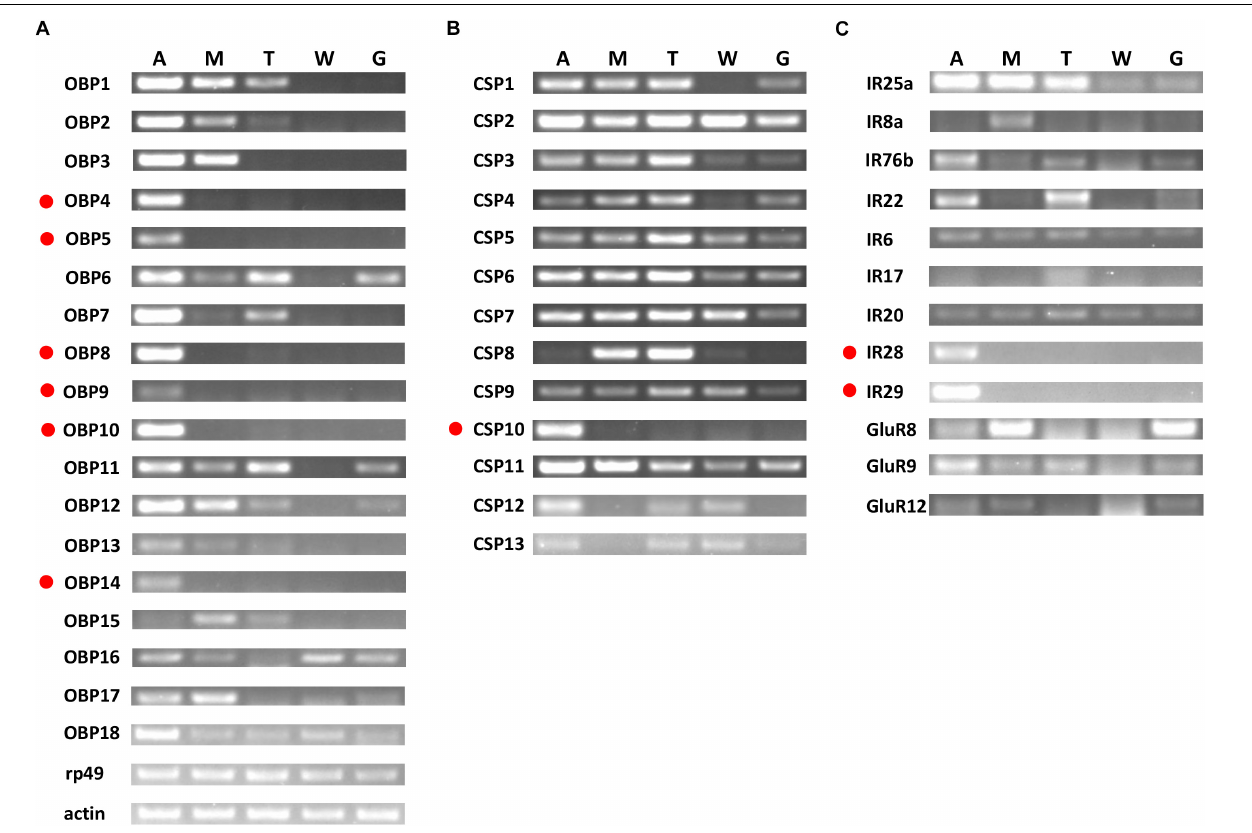
FIGURE 6 | Tissue-specific expression of OchiOBP s, OchiCSP s, and OchiIR s. (A) OBPs. (B) CSPs. (C) IRs. Genes exclusively or predominantly expressed in antennae are labeled in red dots. The β -actin ( Ochi β -actin ) and ribosomal protein 49 ( Ochirp49 ) were used as internal references to test the integrity of each cDNA template. An, antennae; M, maxillary palps; T, foreleg tarsus; W, wings; G,